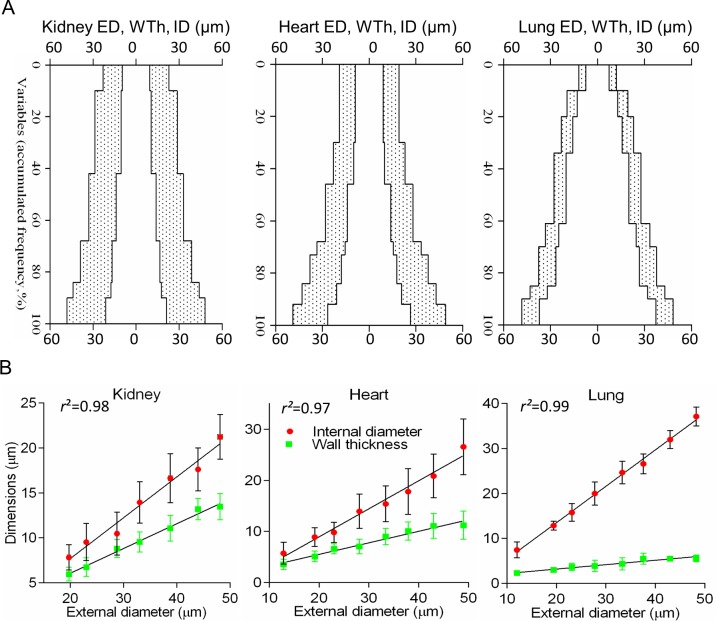
Application of the short fixed intervals significantly improved primary data analysis.(A) Complex profiles were built from the accumulated frequencies (axis Y) of the means of the external diameter (ED), internal diameter (ID), and wall thickness (WTh) for 5-μm ED intervals. In contrast to scatterplots in Fig 2B, terminal arteries exhibited distinctive tapering patterns in organs. Complementary graphs are in S1 Fig. (B) Mean values of ID and WTh for the regular 5-μm ED intervals revealed robust linear regression equations (P<0.001). Complementary graphs are in S2 Fig. Points on the lines are mean ± SD for 5-μm ED intervals.